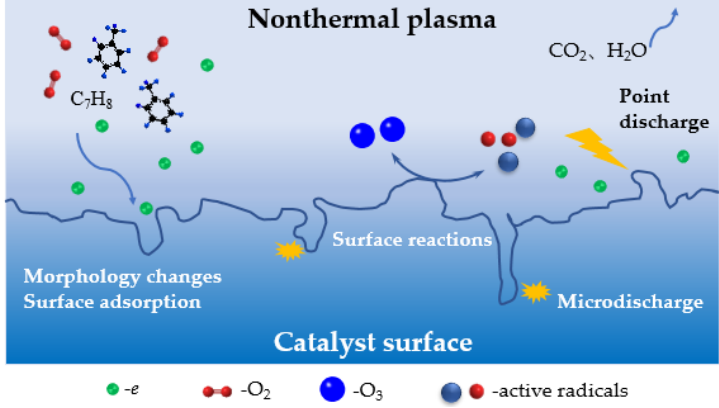
Figure 11. Reaction mechanism for toluene degradation by nonthermal plasma co-catalysts.